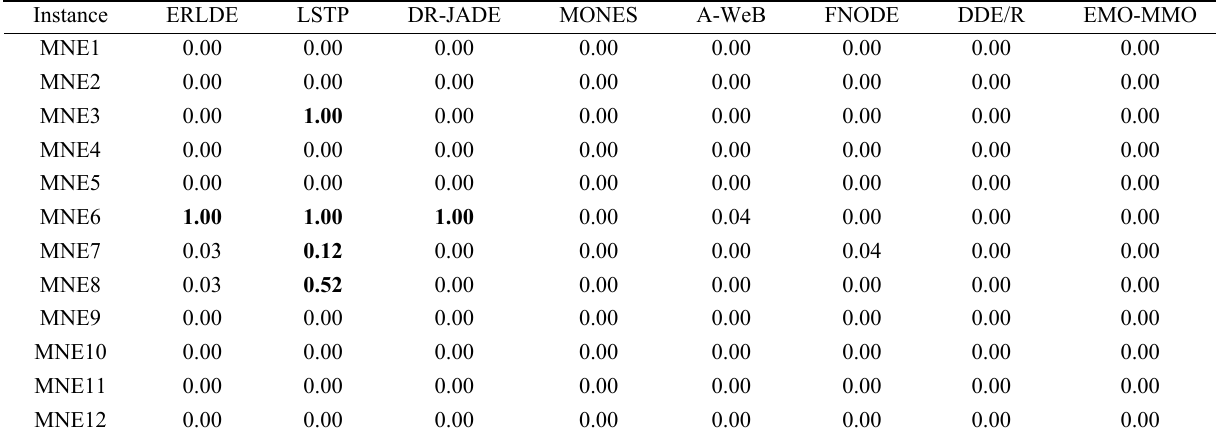
Table A8 Comparison of different algorithms on the new test set in terms of SR